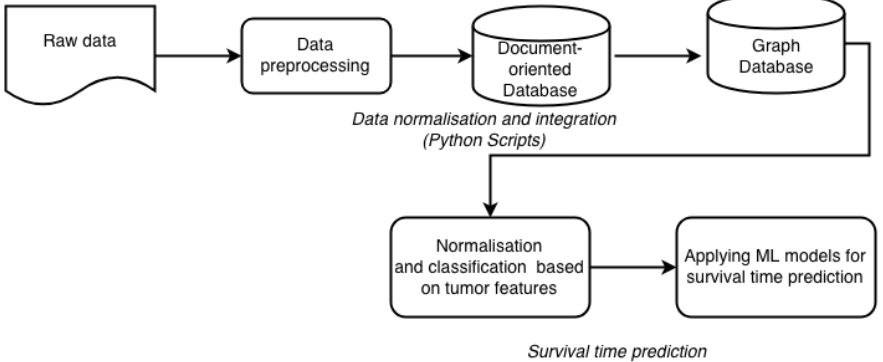
Figure 2. Workflow of data integration and subsequent processing included in our